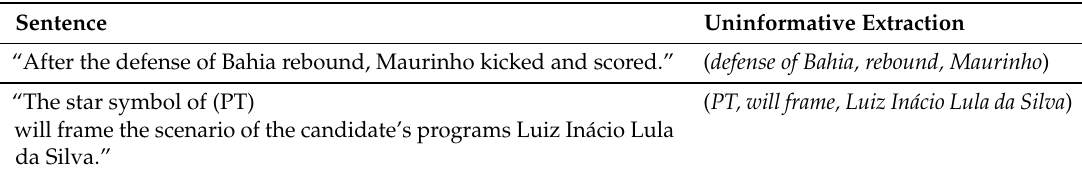
Table 1. Uninformative relations examples